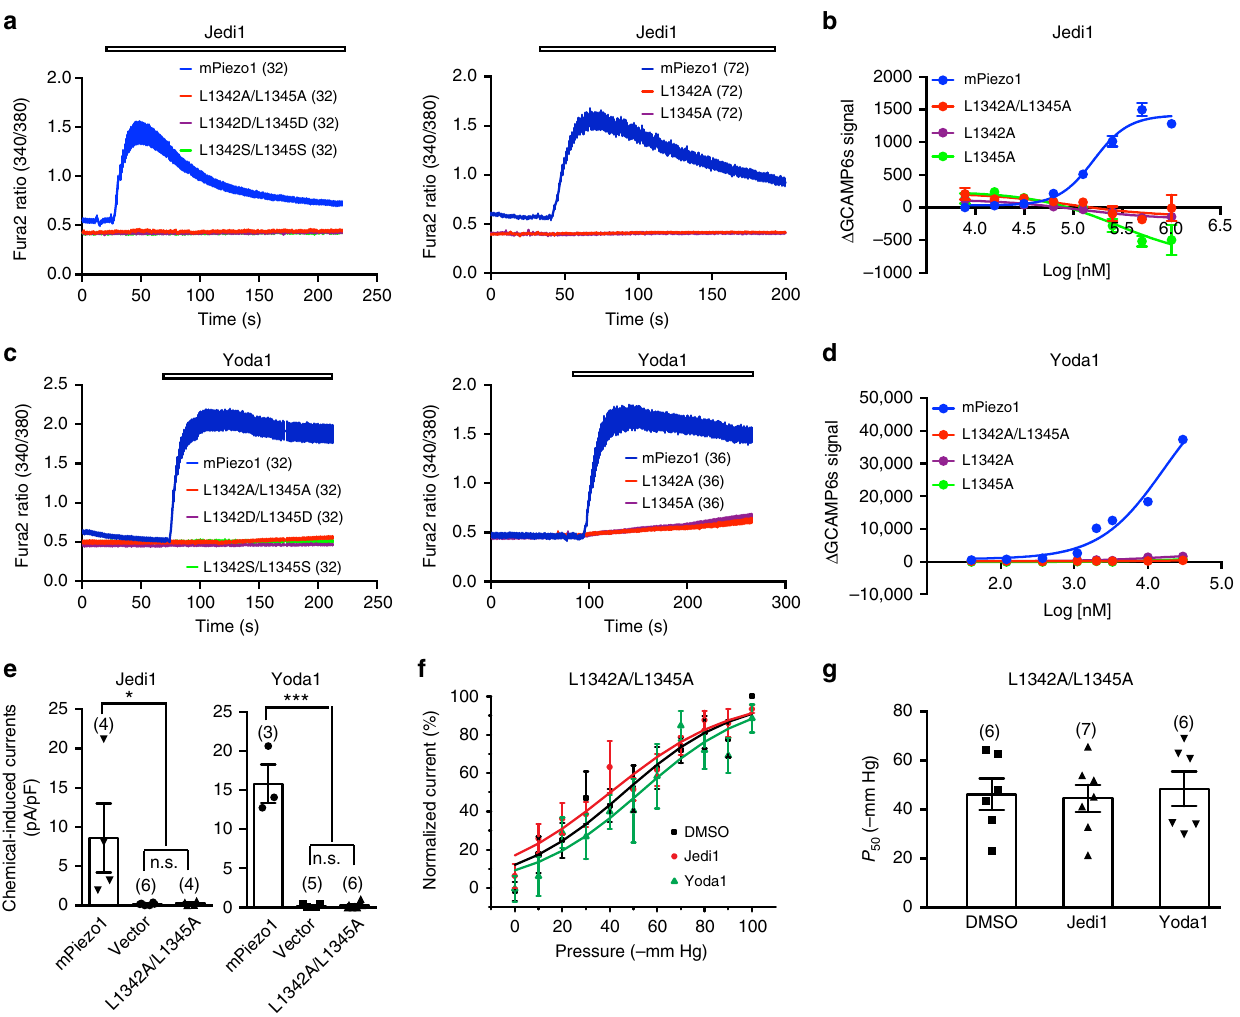
Fig. 6 L1342 and L1345 are essential for Jedi1 and Yoda1 activation of mPiezo1. a , c Representative single-cell Fura-2 Ca 2 + imaging traces showing the average responses of cells transfected with the indicated constructs in response to 1 mM Jedi1 ( a ) or 30 μ M Yoda1 ( c ). b , d Dose response curves of cells transfected with the indicated constructs and GCAMP6s in response to Jedi1 ( b ) or Yoda1 ( d ). The curves were fi tted with a Boltzmann equation. Each data point represents mean ± s.e.m., n = 4 wells. e Scatter plot of the chemical-induced currents from the Piezo1-KO-HEK cells transfected with the indicated constructs. Statistical signi fi cance was assessed using one-way ANOVA with multiple comparison test. f Pressure-current relationships of the stretch- induced currents of the L1342A/L1345A mutant under the indicated compound conditions. The curves were fi tted with a Boltzmann equation. g Scatter plot of the P 50 calculated from fi t of the pressure-current relationship of individual recordings with a Boltzmann equation. Statistical signi fi cance was assessed using one-way ANOVA with multiple comparison test. Data shown as mean ± s.e.m., and the recorded cell number is labeled above the bar. * P < 0.05, *** P <